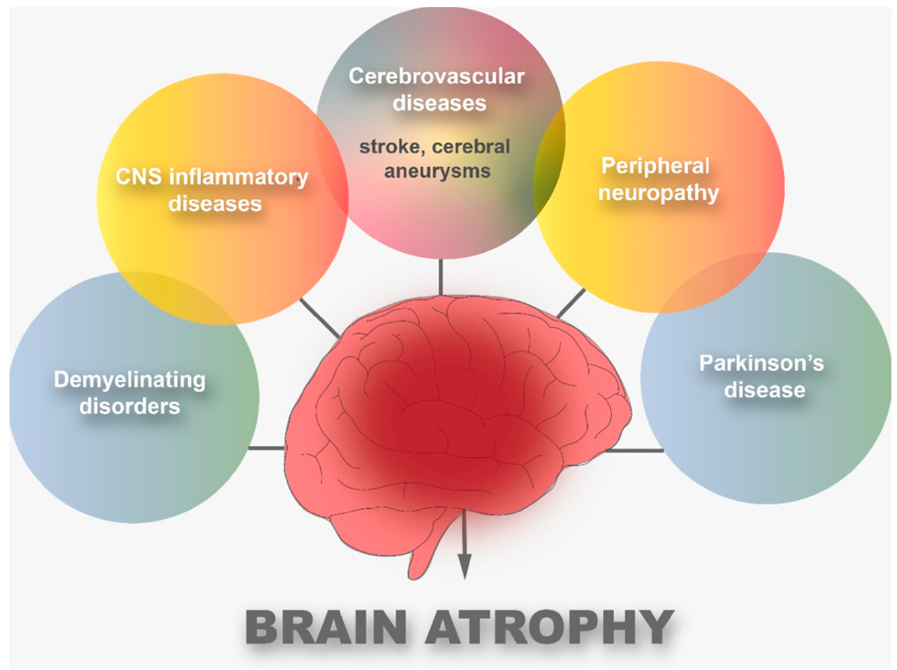
Figure 2. Common diseases that cause brain atrophy.